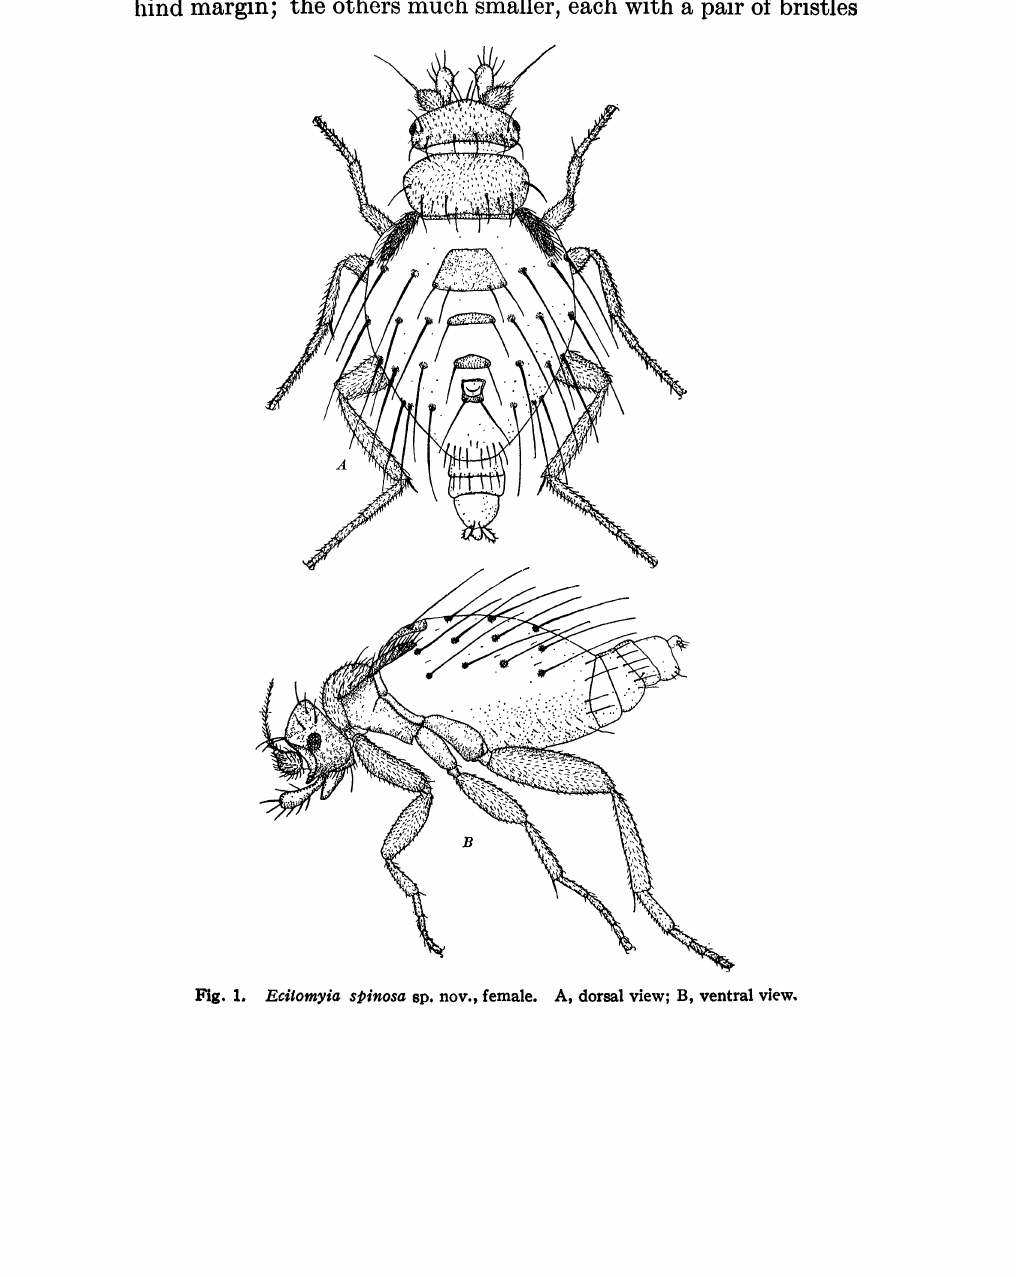
Fig. 1. litomyia spinosa sp. nov., female. A, dorsal view; B, ventral